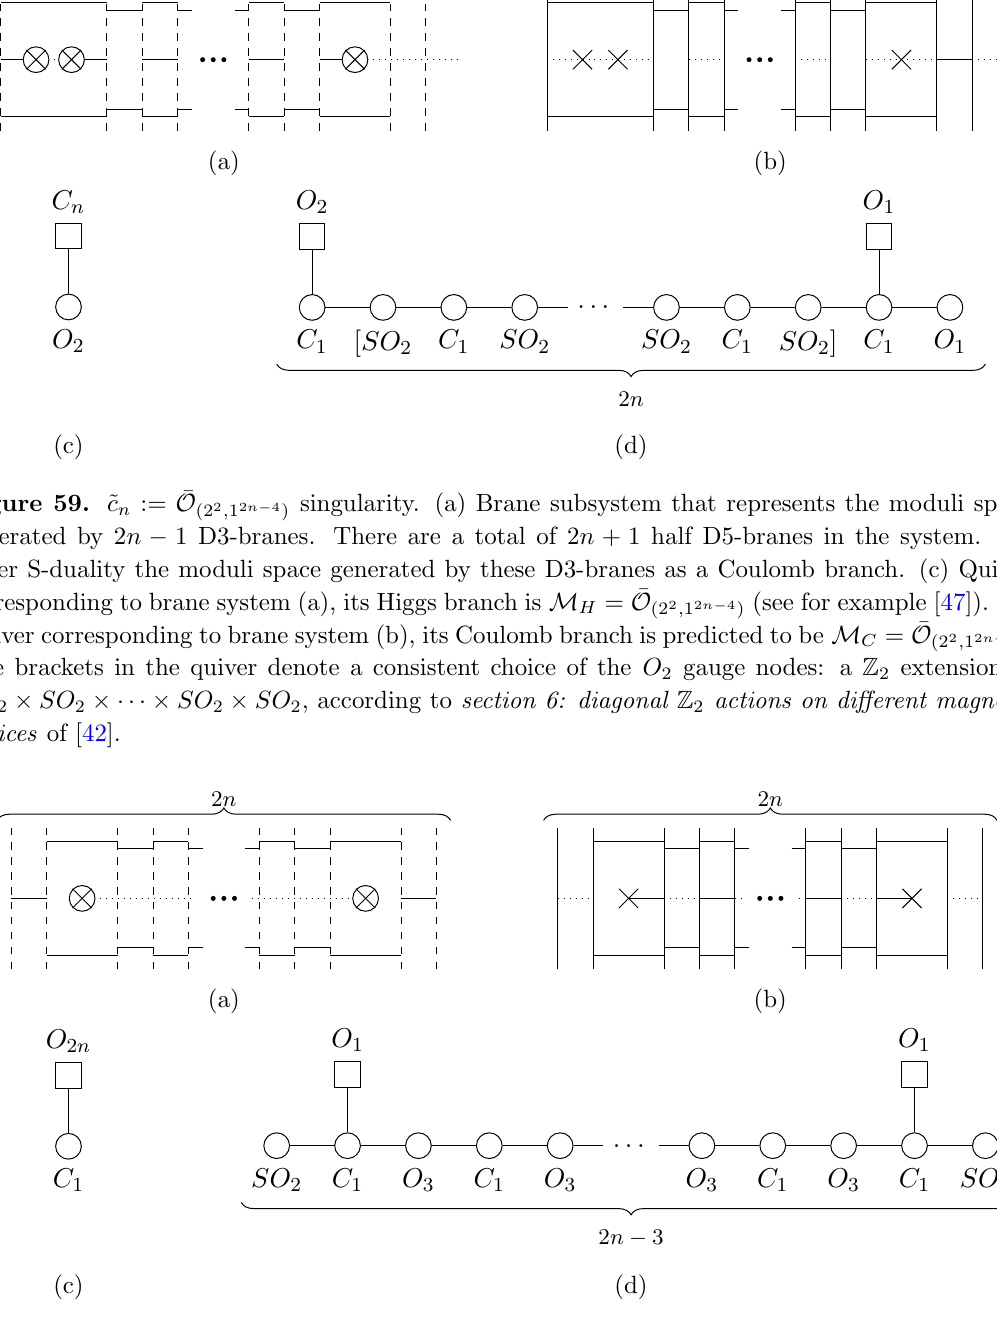
Figure 60. d n singularity. (a) Brane subsystem that represents the moduli space generated by 2 n (cid:0) 3 D3-branes. There are 2 n half D5-branes in the system. (b) After S-duality the moduli space generated by these D3-branes as a Coulomb branch. (c) Quiver corresponding to brane system (a), (cid:26) so (2 n ). (d) Quiver corresponding to brane system (b), its Higgs branch is M H = (cid:22) O (2 2 ; 1 2 n (cid:0) 4 )